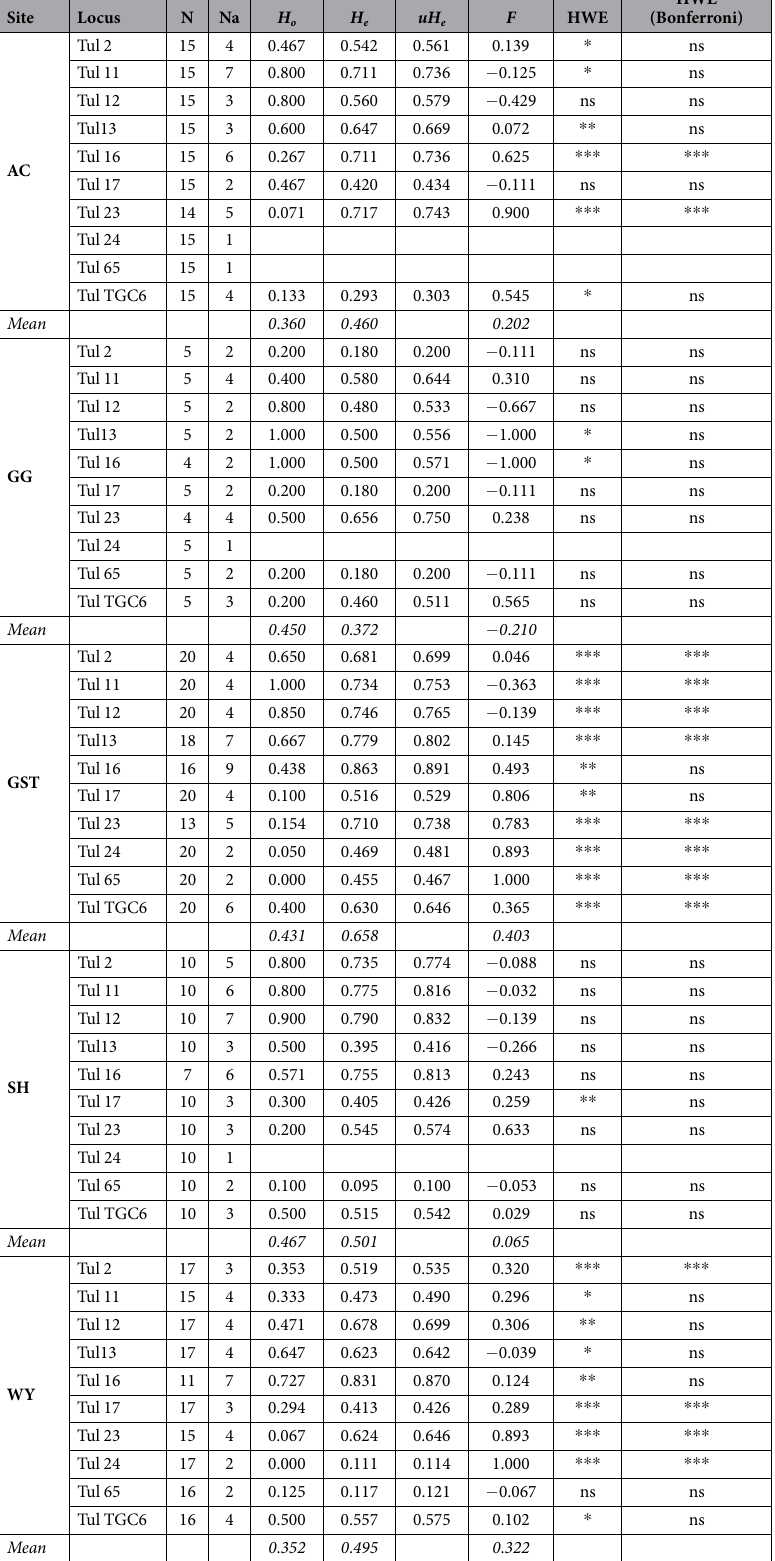
Table 4. Measures of SSR diversity for Tulasnella prima sampled at sites in Kosciuszko National Park: Number of isolates (N), number of alleles (Na), observed heterozygosity ( H o ), expected heterozygosity ( H e ), unbiased expected heterozygosity ( uH e ), fixation index ( F ) and significance for Hardy-Weinberg equilibrium before and after Bonferroni correction. Key: ns = not significant, * P < 0.05, ** P < 0.01, *** P <